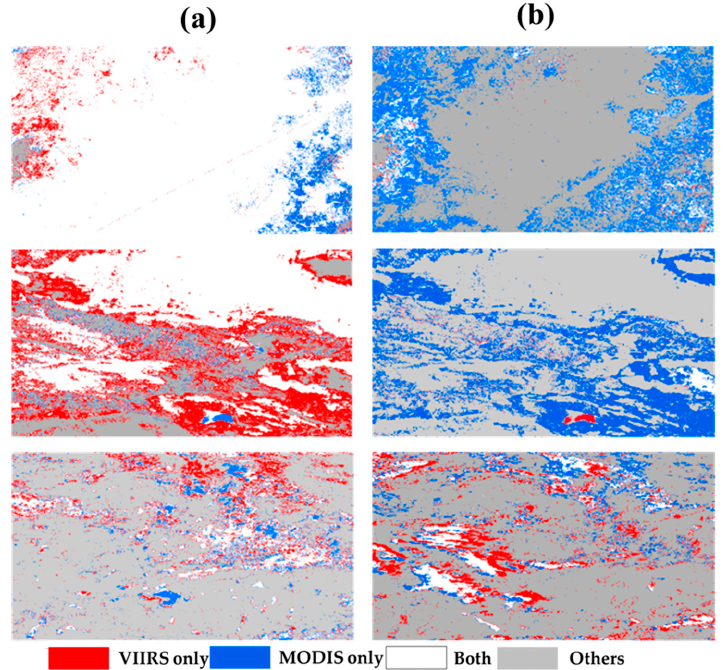
Figure 7. Snow and cloud cover distribution differences. ( a ) Snow cover distribution difference map, with the red color indicating snow in VIIRS only and the blue color showing snow in MODIS only. ( b ) Cloud cover distribution difference map, with the red color indicating clouds in VIIRS only and the blue color showing clouds in MODIS only. Three images were randomly chosen in the NE (2020002), NW (2020038) and QT (2020047) regions, shown from top to bottom. VIIRS (MODIS) represents the snow or clouds in VIIRS (MODIS) only. ‘Both’ represents snow or clouds in both products.